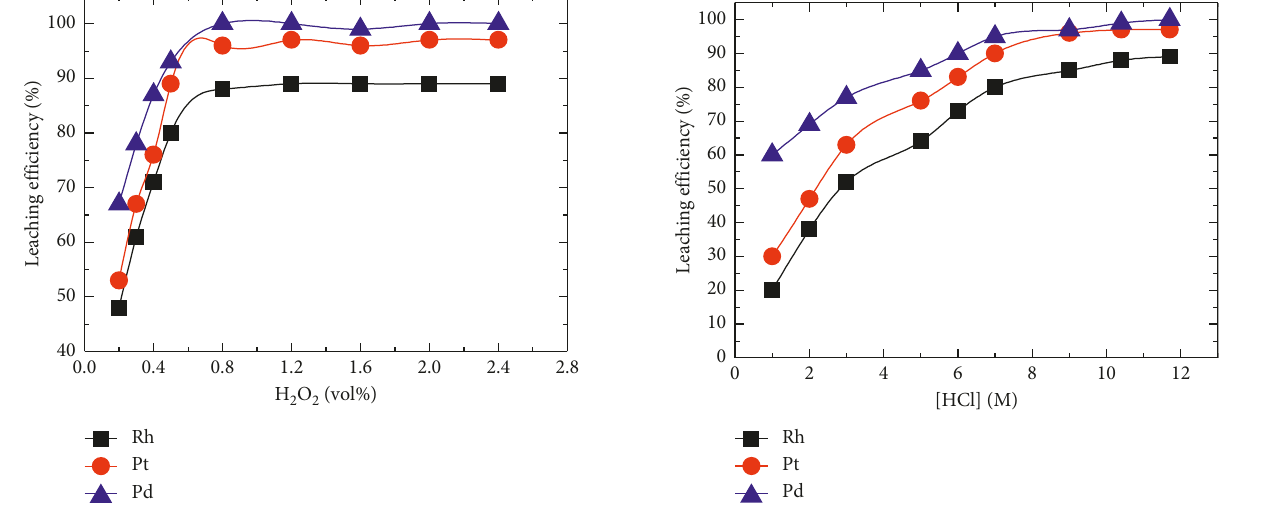
Figure 1: Effect of changing H Figure 2: Effect of changing HCl concentration with addition of 2 O 2 /HCl volume percentage on PGM leaching efficiencies at 60 ° C for 3hours.